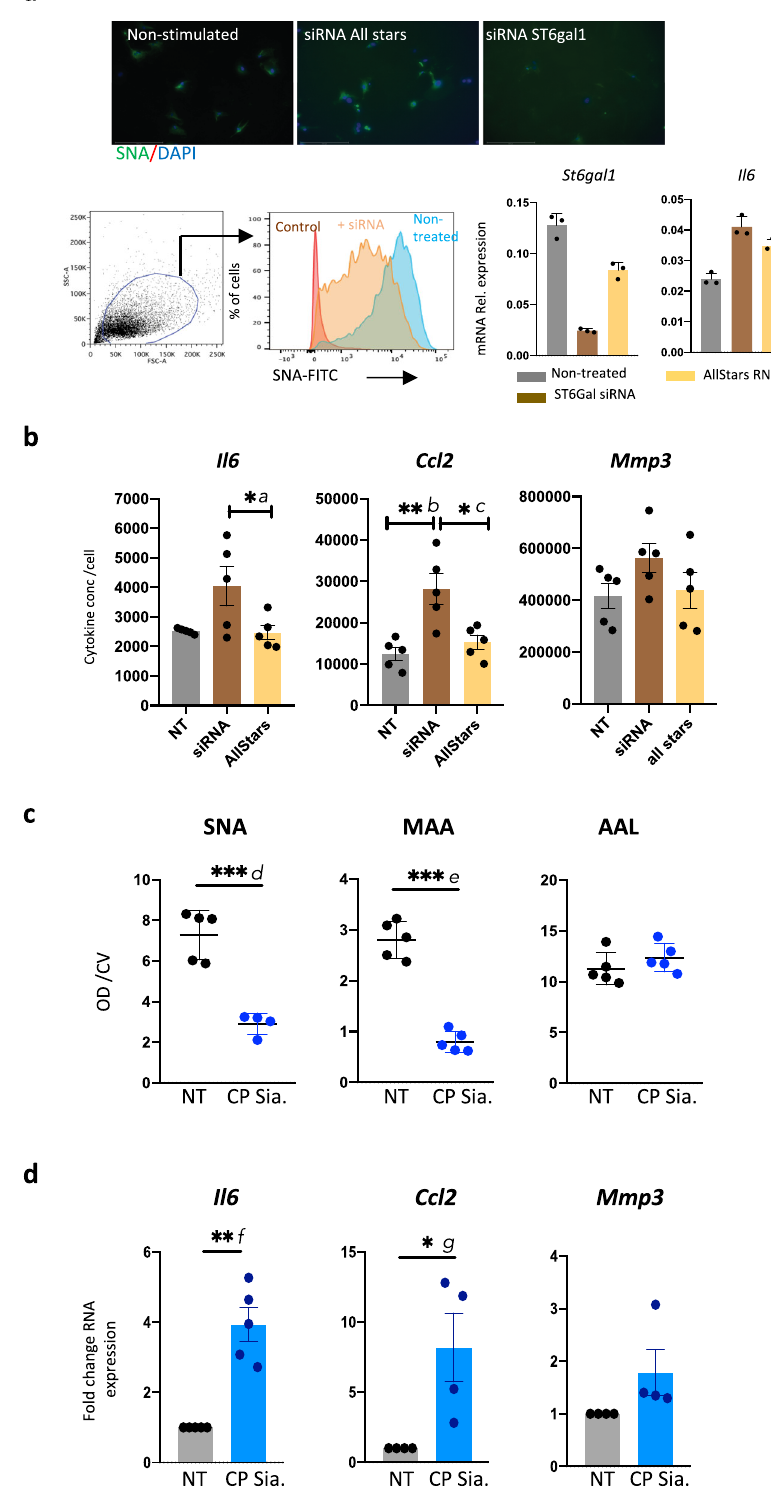
other immune cells, promoting trans or cis interactions. Siglecs (sialic acid-binding immunoglobulin-type lectins) are a family of immune regulatory proteins primarily found on hematopoietic cells. Consistent with our proposed homeostatic role for sialic acid in the synovium, Siglec-9 protected mice against experi- mental arthritis, although authors reported that it had no effect on SFs 44 . Instead, Siglec-9 inhibited NF-kB activation in human